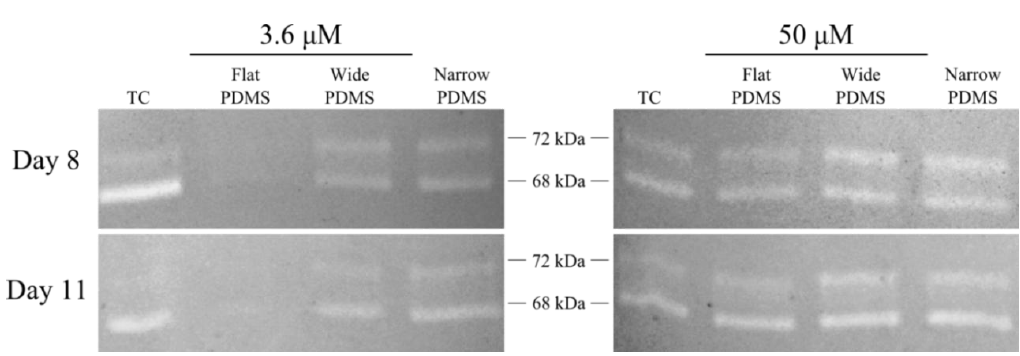
Figure 1. Gelatin zymogram demonstrating MMP-2 activity (indicated by white bands). Subclone 4 MC3T3-E1 cell extracts on PDMS and tissue culture polystyrene (TC) surfaces in serum level zinc (3.6 µM) and zinc-rich (50 µM) media conditions were isolated on day 8 and 11, and normalized to a total protein concentration of 17.90 µg per well. Zymograms shown are representative of data from two independent experiments.